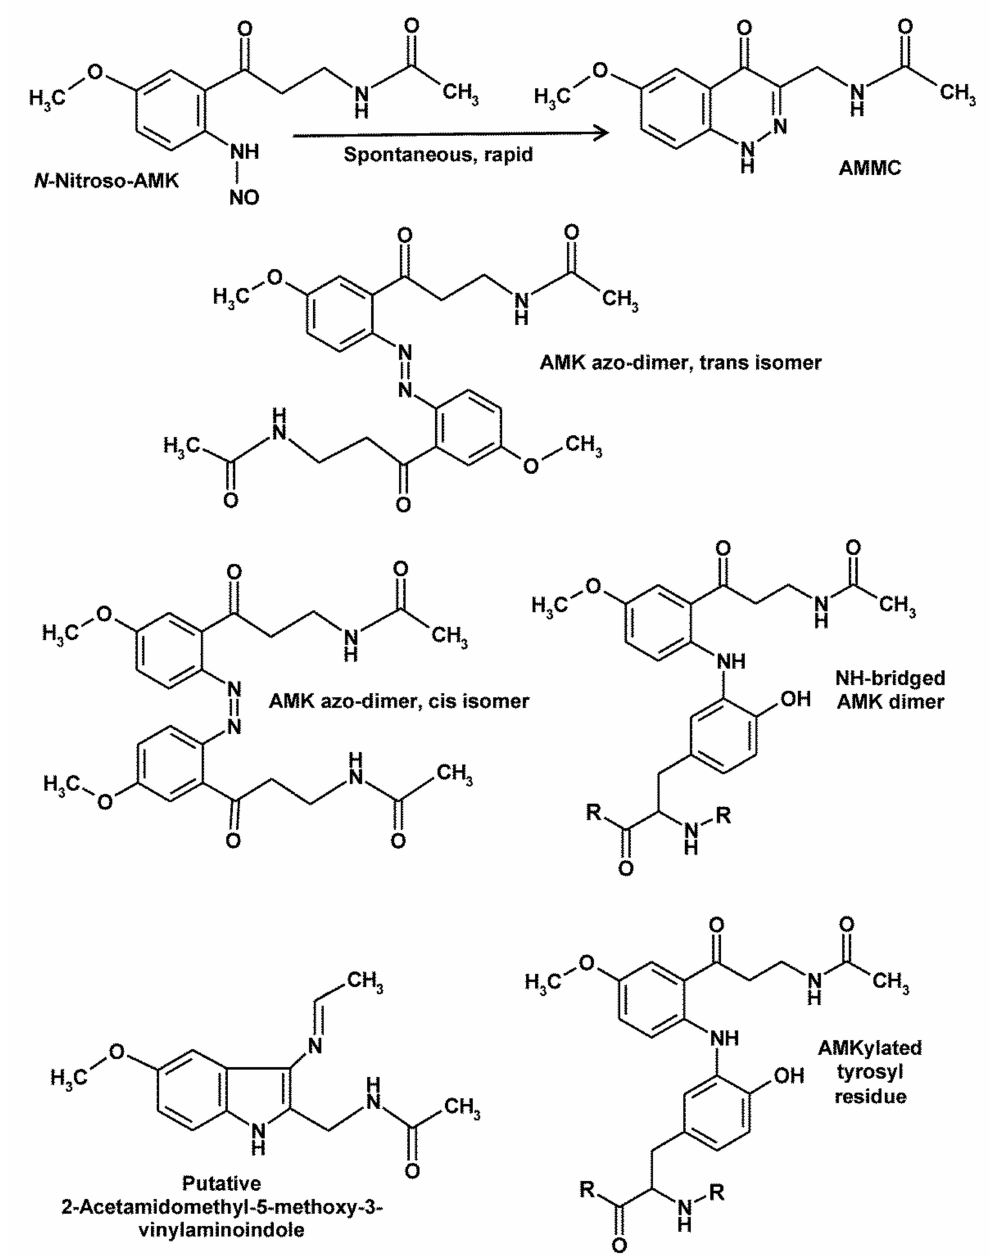
Figure 4. Nitrosylation of AMK to AMMC and oxidative products (dimers, putative vinylaminoindole, tyrosyl adduct) of AMK. Abbreviation: AMMC, 3-acetamidomethyl-6-methoxy-cinnol- inone. The structure of 2-acetamidomethyl-5- methoxy-3-vinylaminoindole is still hypothetic, but consistent with high-resolution MS [127]. Dimerization is indicative of AMK’s potential for nitrogen-dependent adduct formation, as in the interaction with tyrosyl residues. The similarity of the vinylaminoindole to melatonin would suggest possible N -nitrosylation as known for